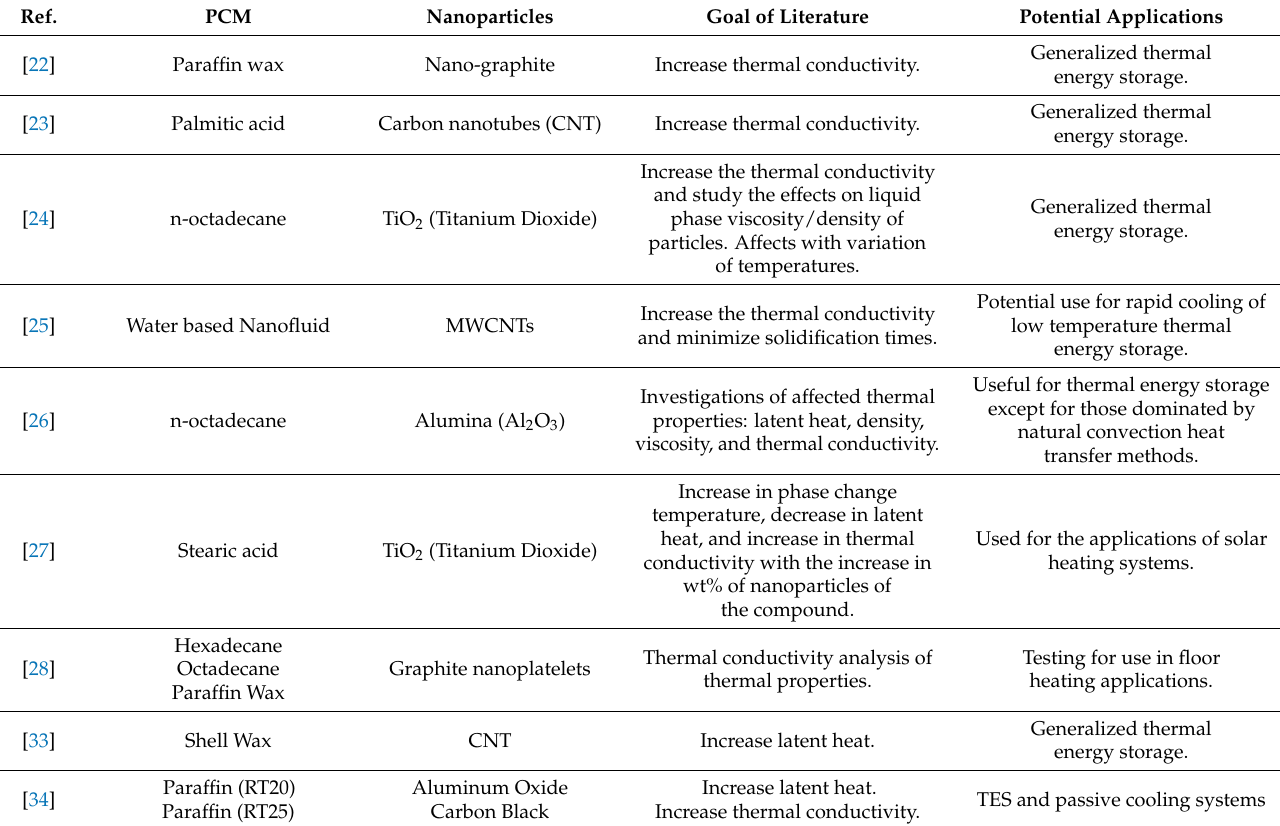
Table 1. Samples of commonly used PCMs and